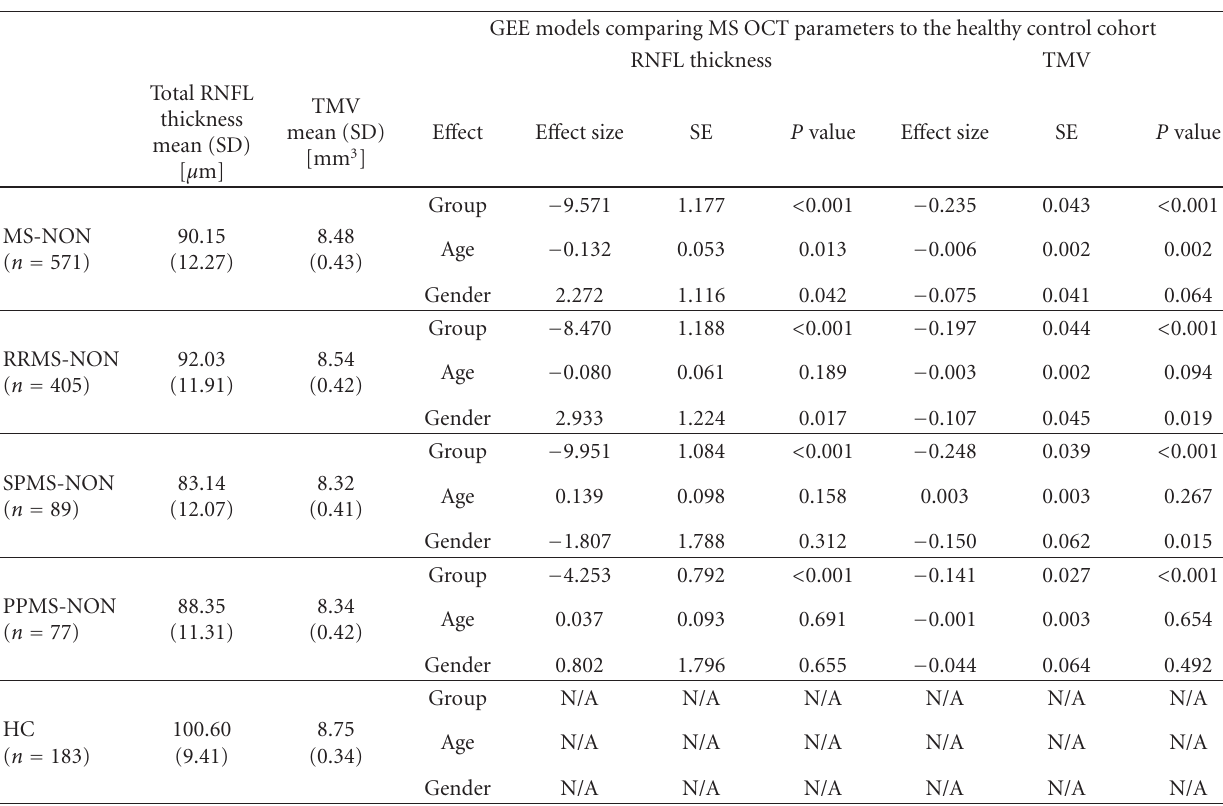
Table 2: OCT results for the subtypes of MS patients without a history of optic neuritis (NON). Total retinal nerve fiber layer (RNFL) thickness (in µ m) and total macular volume (TMV in mm 3 ) are given as mean values with standard deviation (SD). Generalized estimation equation (GEE) models were used to compare the MS cohorts to healthy controls. GEE models estimate the e ff ect size with standard error (SE) and the respective P